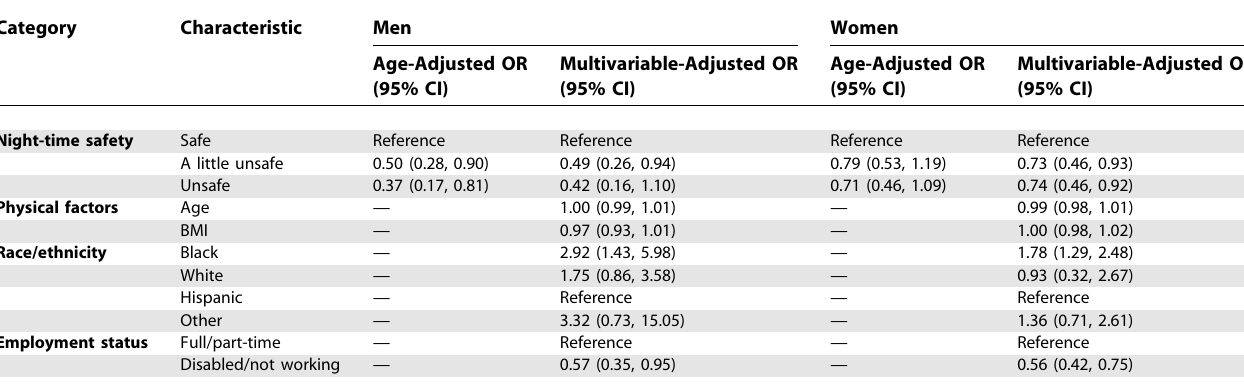
Table 4. Perceived Night-Time Neighborhood Safety and Physical Activity Self-Efficacy Category